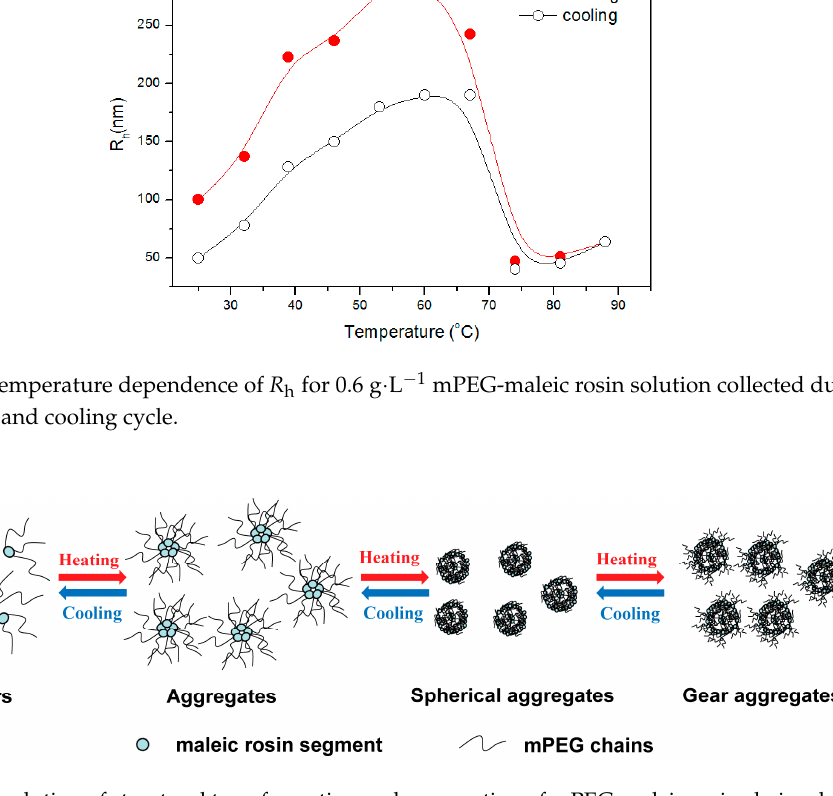
Figure 10. Temperature dependence of R h for 0.6 g·L − 1 mPEG-maleic rosin solution collected during one heating and cooling cycle.